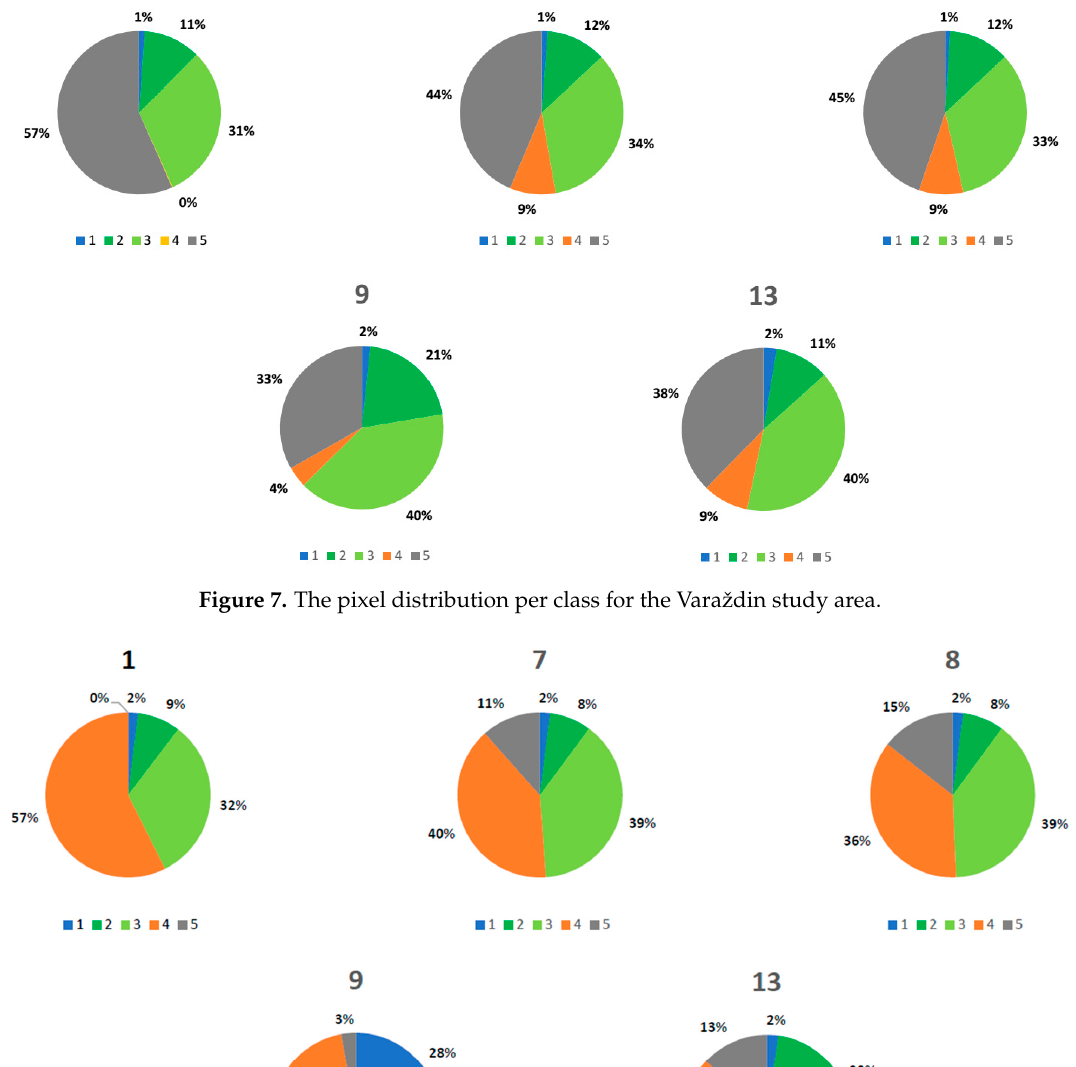
Figure 8. The pixel distribution per class for the Osijek study area.